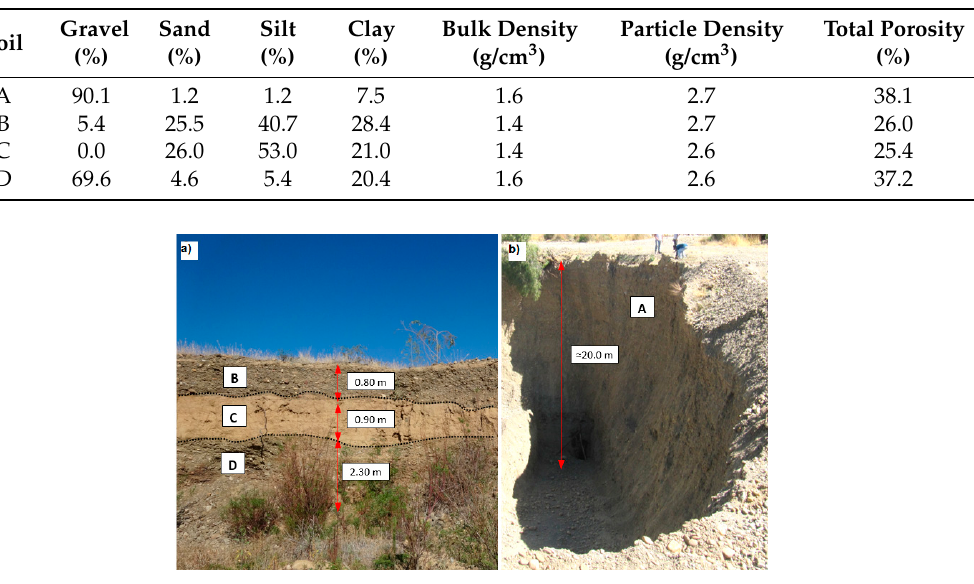
Figure 3. Typical stratigraphy in the Punata alluvial fan. ( a ) The soil profile displays a layer with three different soils (B, C, and D); while ( b ) shows a pit with a soil type A (coarse soil, composed by